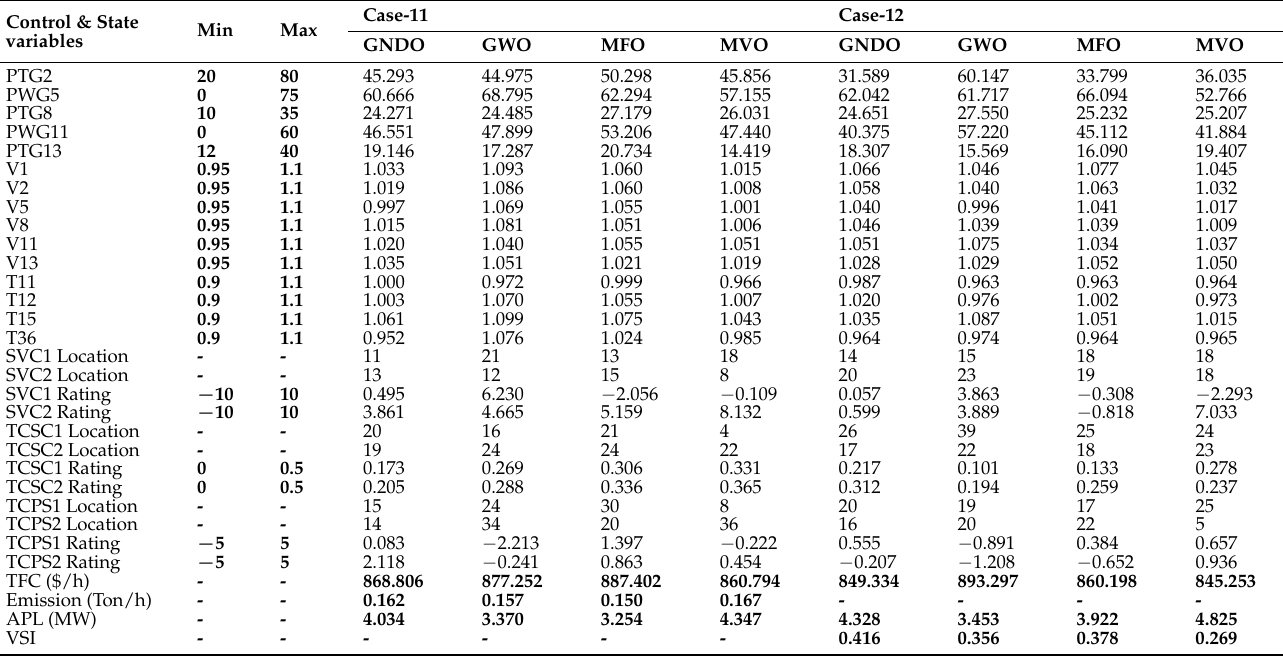
Table 15. Multi-objective simulation results for case 11 and case 12.